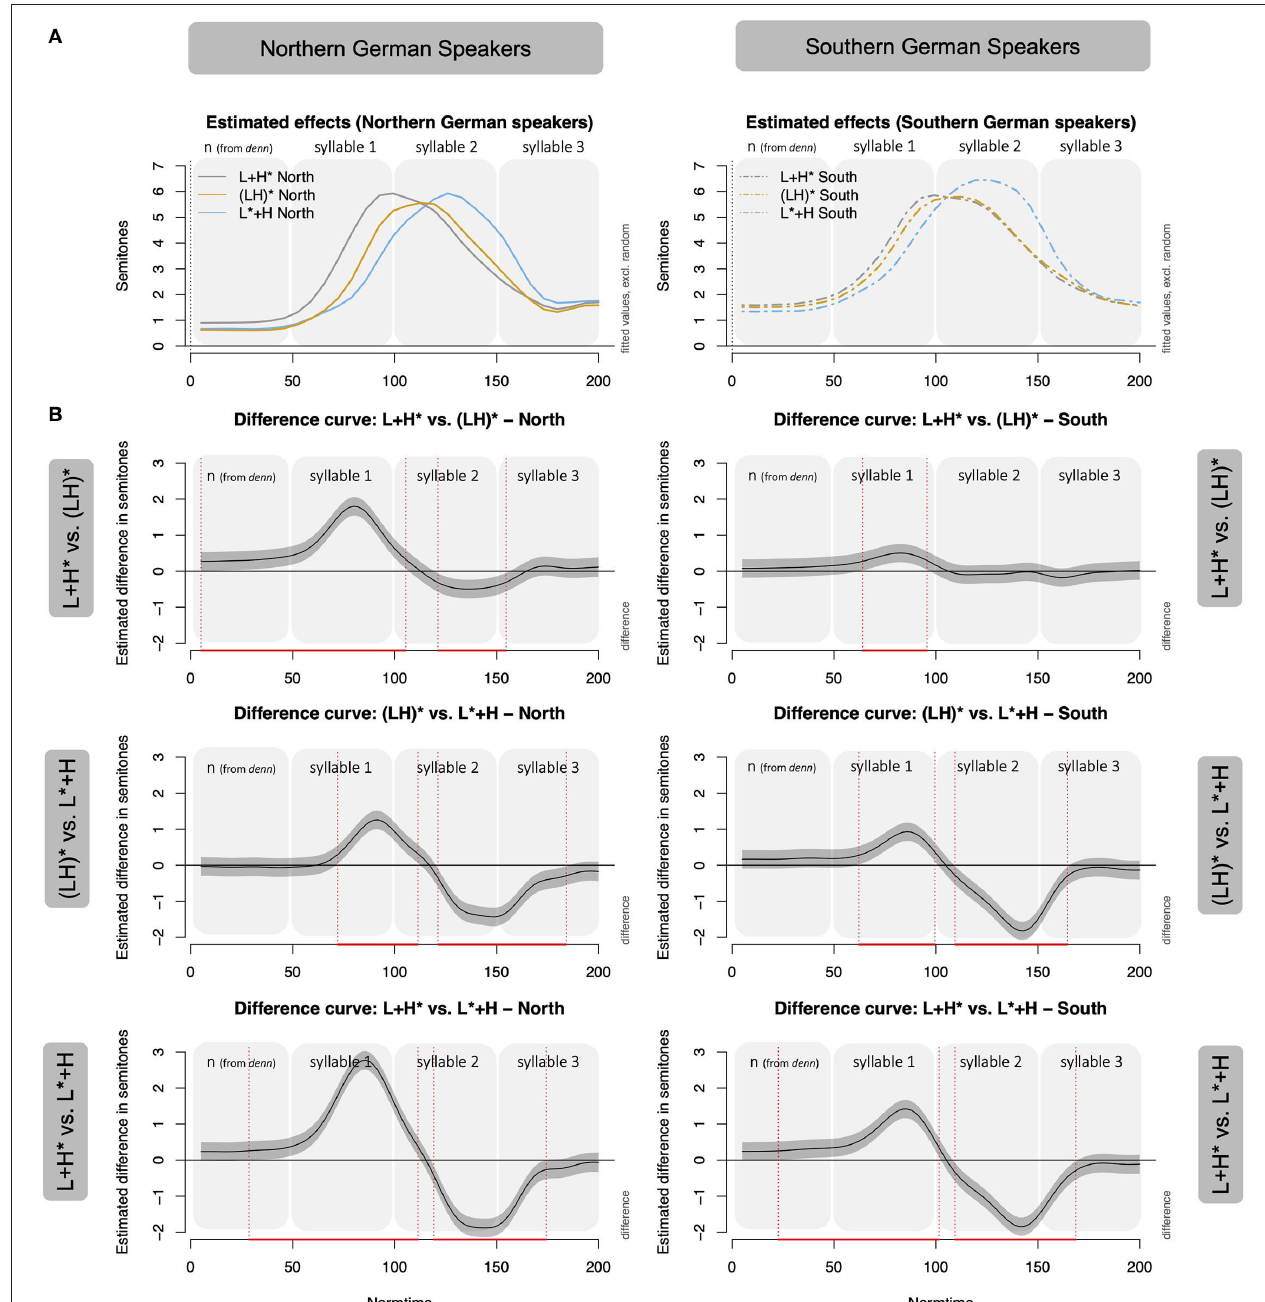
FIGURE 4 | GAMM results. (A) Predicted f0 values in the three intonation conditions [L + H* in gray, (LH)* in orange, and L* + H in blue] for Northern German speakers (left panel) and Southern German speakers (right panel). (B) Predicted difference curves (pairwise comparisons between contours), for Northern German speakers (left panel) and Southern German speakers (right panel). The gray shading displays the 95% CI (confidence interval) of the predicted mean difference. The difference becomes significant if zero is not included in the 95% CI. This is marked by the vertical red lines.